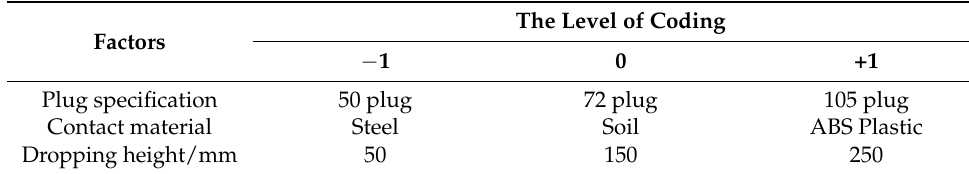
Table 2. Test factors and